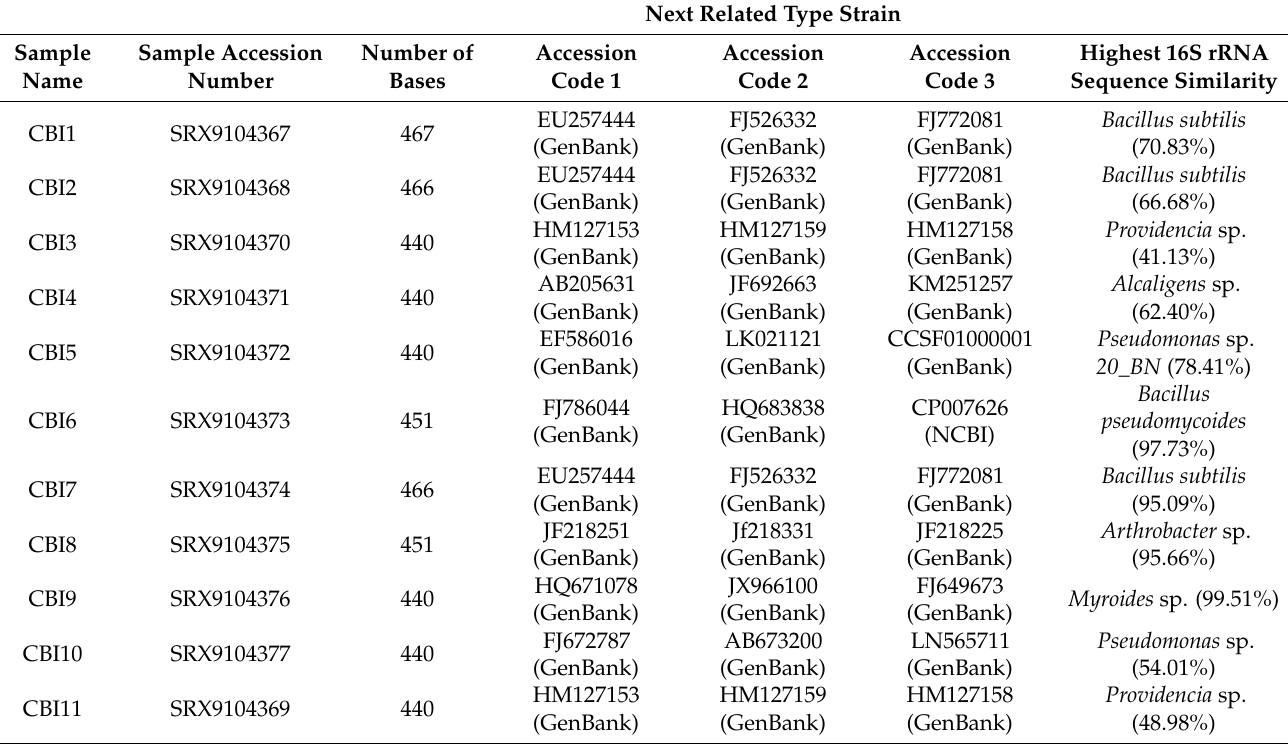
Table 3. Taxonomic abundance ratio (%) of compost bacterial isolates. Next Related Type